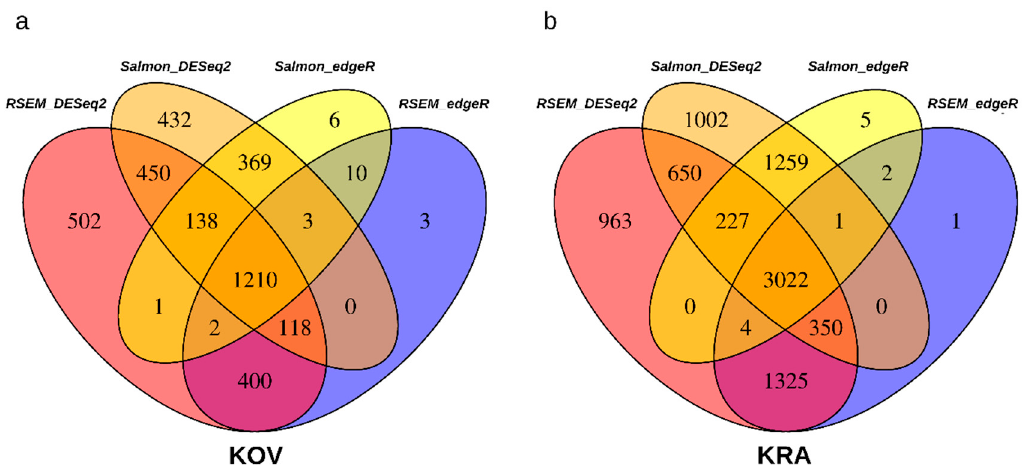
Figure 3. Numbers of the differentially expressed genes identified by four different bioinformatic pipelines in ( a ) the KOV transcriptome, ( b ) in the KRA transcriptome.